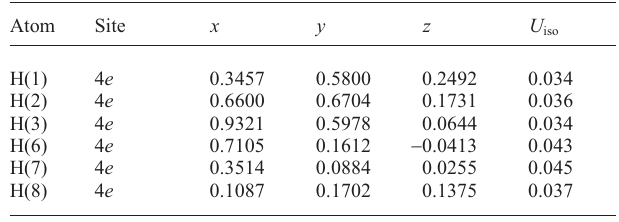
Table 2. Atomic coordinates and displacement parameters (in Å 2 )